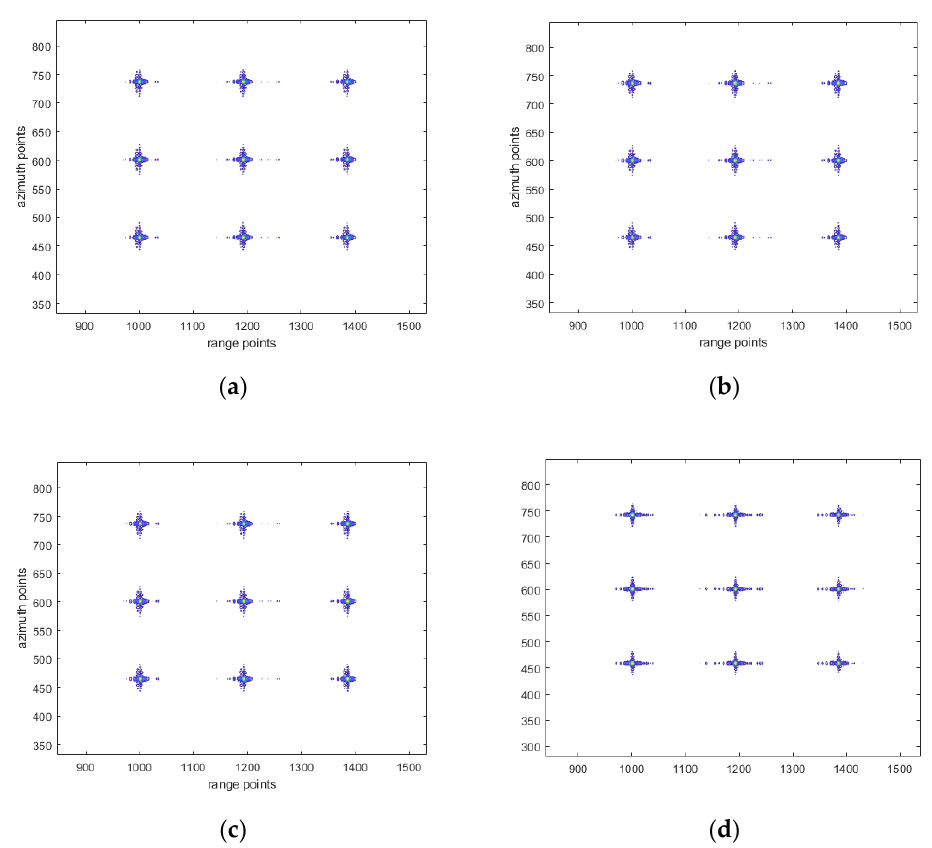
Figure 6. The images generated by using the FBP algorithm when the MBS is at apogee ( a ), perigee ( b ), ascending node ( c ), and descending node ( d ), and their respective time is consistent with the time in Tables 2 and 3.